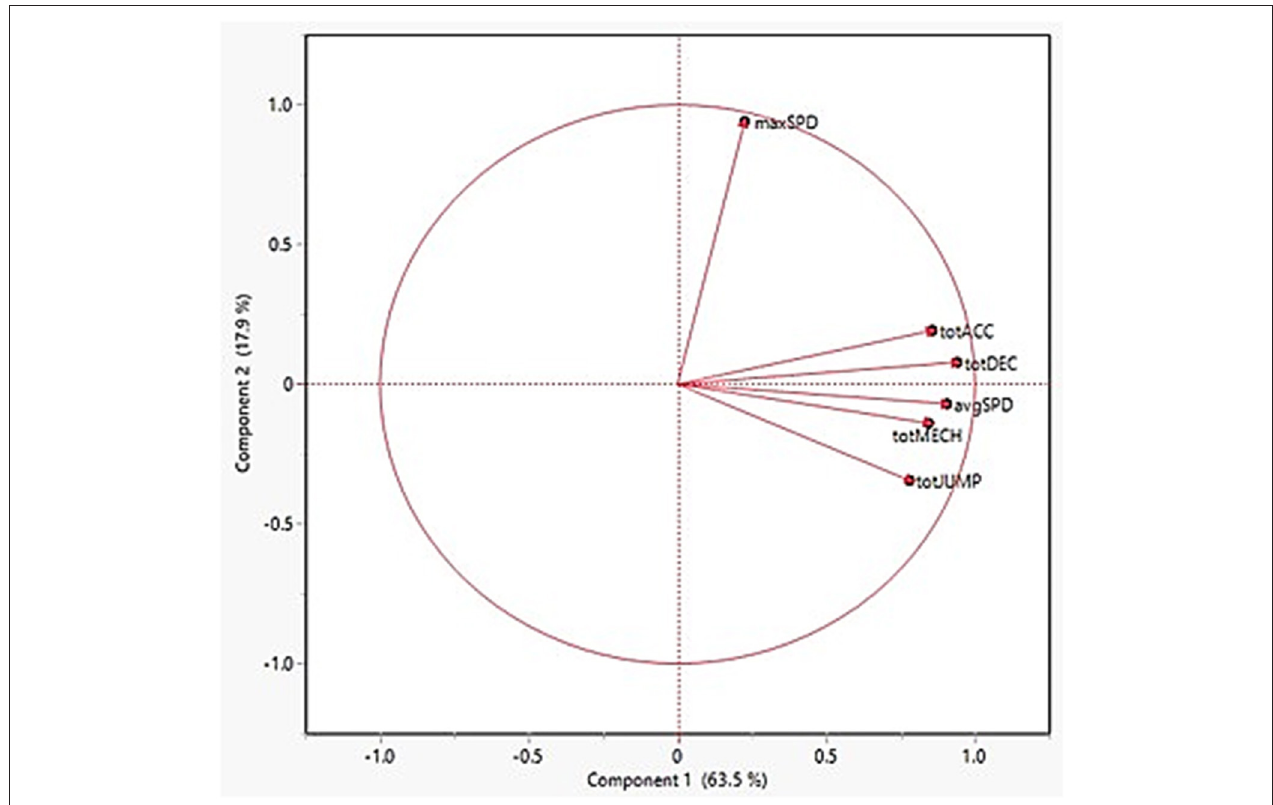
FIGURE 2 | Loading plot for principal components 1 and 2. Total mechanical load, totMECH; jump load, totJUMP; accelerations, totACC; decelerations, totDEC; average speed, avgSPD; maximum speed,